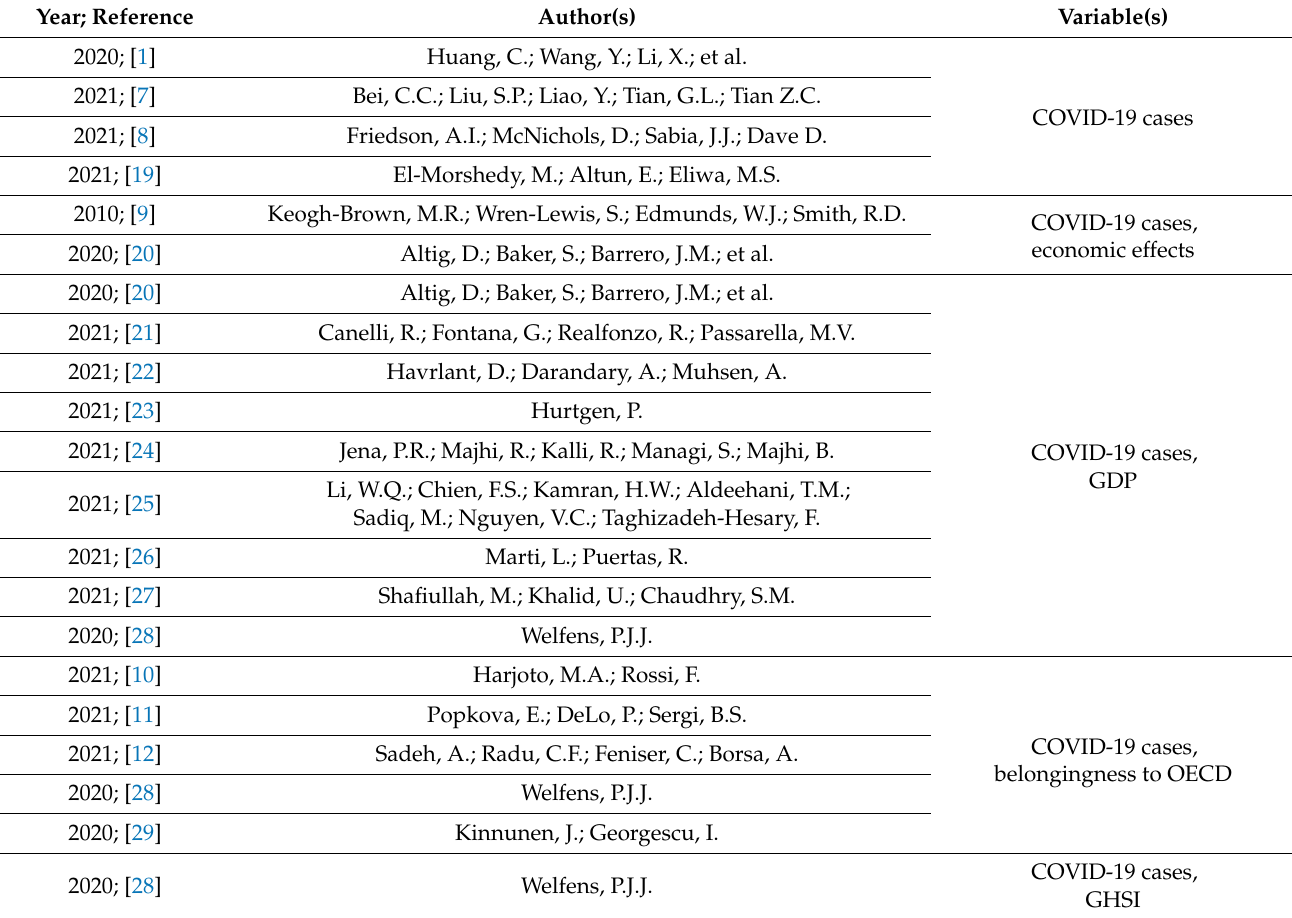
Table 1. Variable(s) used in the literature for the indicated year, reference, and